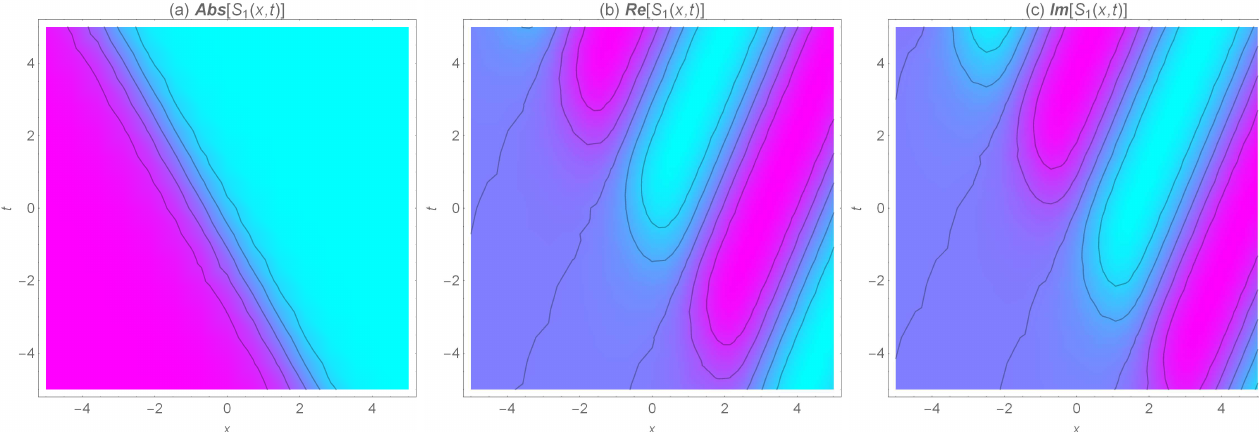
Figure 2. The 2D density of the wave surfaces for the absolute, real, and imaginary values of the dark (kink) soliton solution for b = 0.9, c = − 0.3, s = 1.5, k = 1, ϑ 0 = 0.2, ε 1 = 1, ε 2 = 1, ε 3 = 1.2, Ω = 0.5.